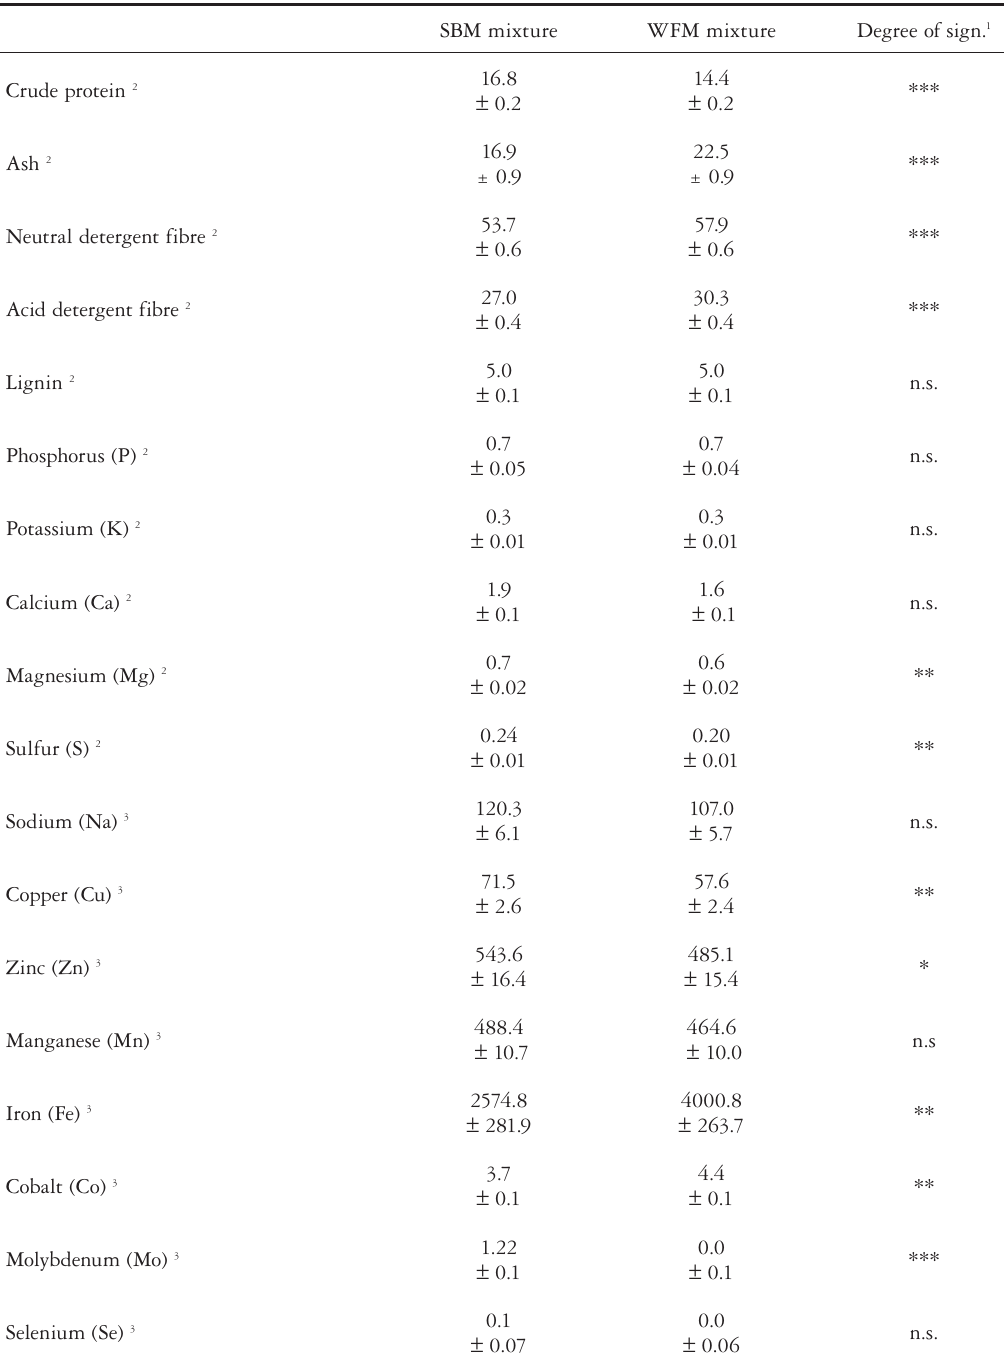
Table 3. Nutrient composition on a dry matter (DM) basis (least-squares means ± standard errors) in fecal samples from reindeer fed the two feed mixtures used in the study; soybean meal mixture (SBM, n = 7 samples) and fishmeal mixture (WFM, n = 8